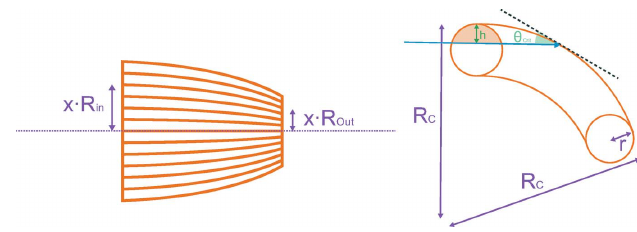
Figure 16 Parametrization of the polycapillary optic (left) and sketch of the bending radius of a single capillary (right).